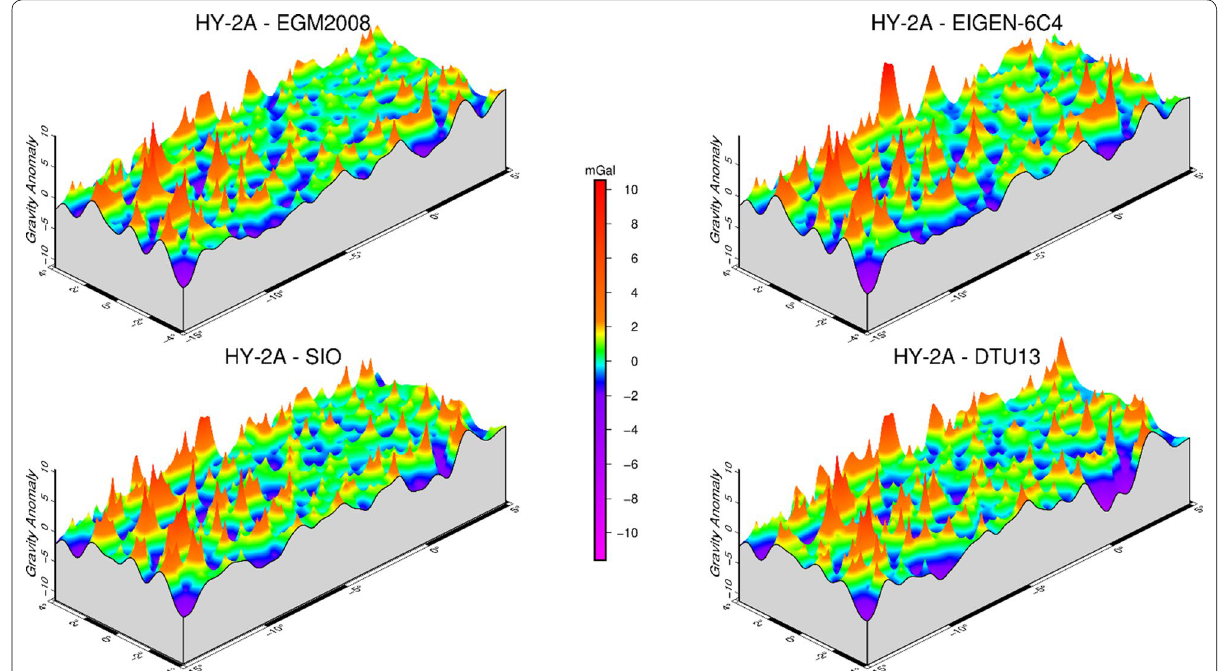
Fig. 10 Differences between HY-2A-derived gravity anomaly and the other